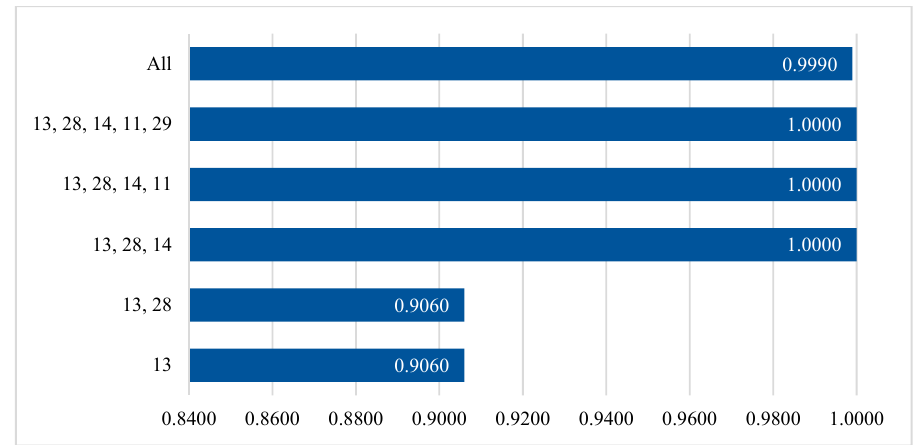
Figure 7. Accuracy results for the testing set for different numbers of features when detecting attack and benign classes.